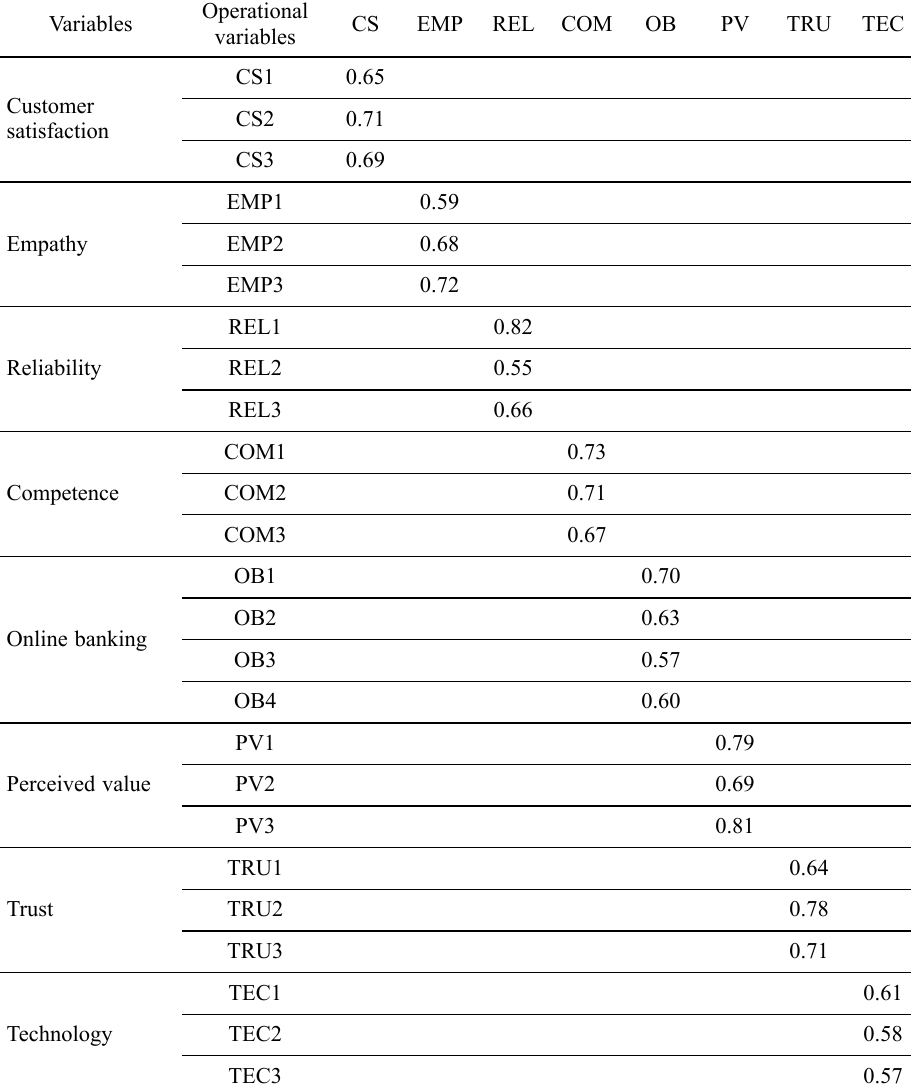
Table 4. Results of Principal component